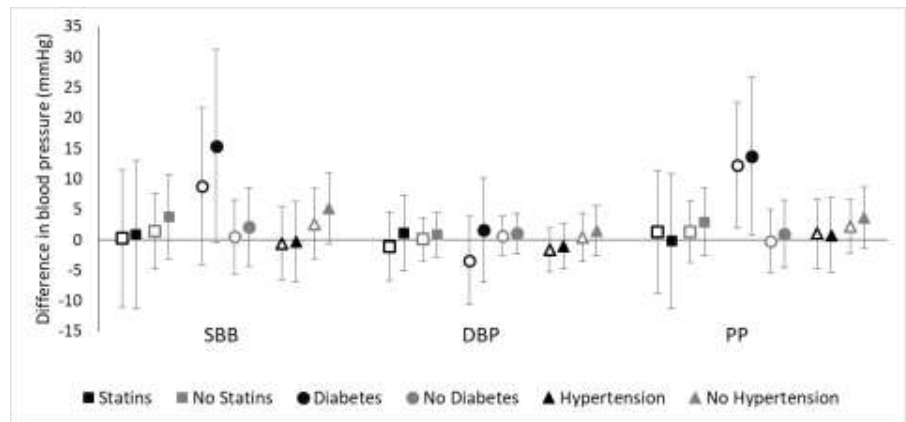
Figure 3. Effect modification of the association of ln(TAA-PNC) with blood pressure by statin medication use, diabetes status, and hypertension status. Open markers represent unadjusted associations (Model A) while solid markers represent adjusted associations (Model B; adjusted for BMI, sex, smoking, physical activity, and diet as fried food consumption).